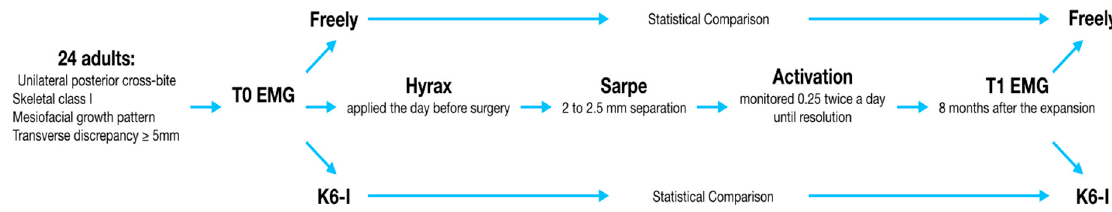
Figure 4. The flowchart of the